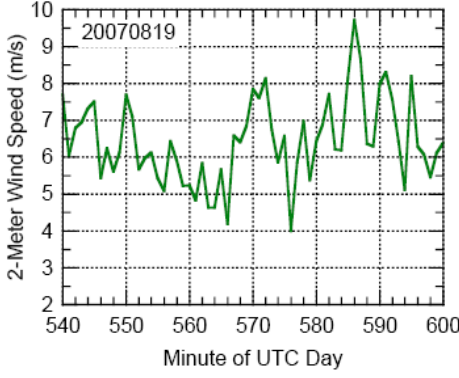
Fig. 5 One-minute rain rate differences TN-WP and rain rate from WP for the first 60- Fig. 5. One-min rain rate differences TN-WP and rain rate from minute period in Fig. 4. Solid lines are one-minute observed values and dashed lines WP for the first 60-min period in Fig. 4. Solid lines are one-min are smooth fits. observed values and dashed lines are smooth fits.